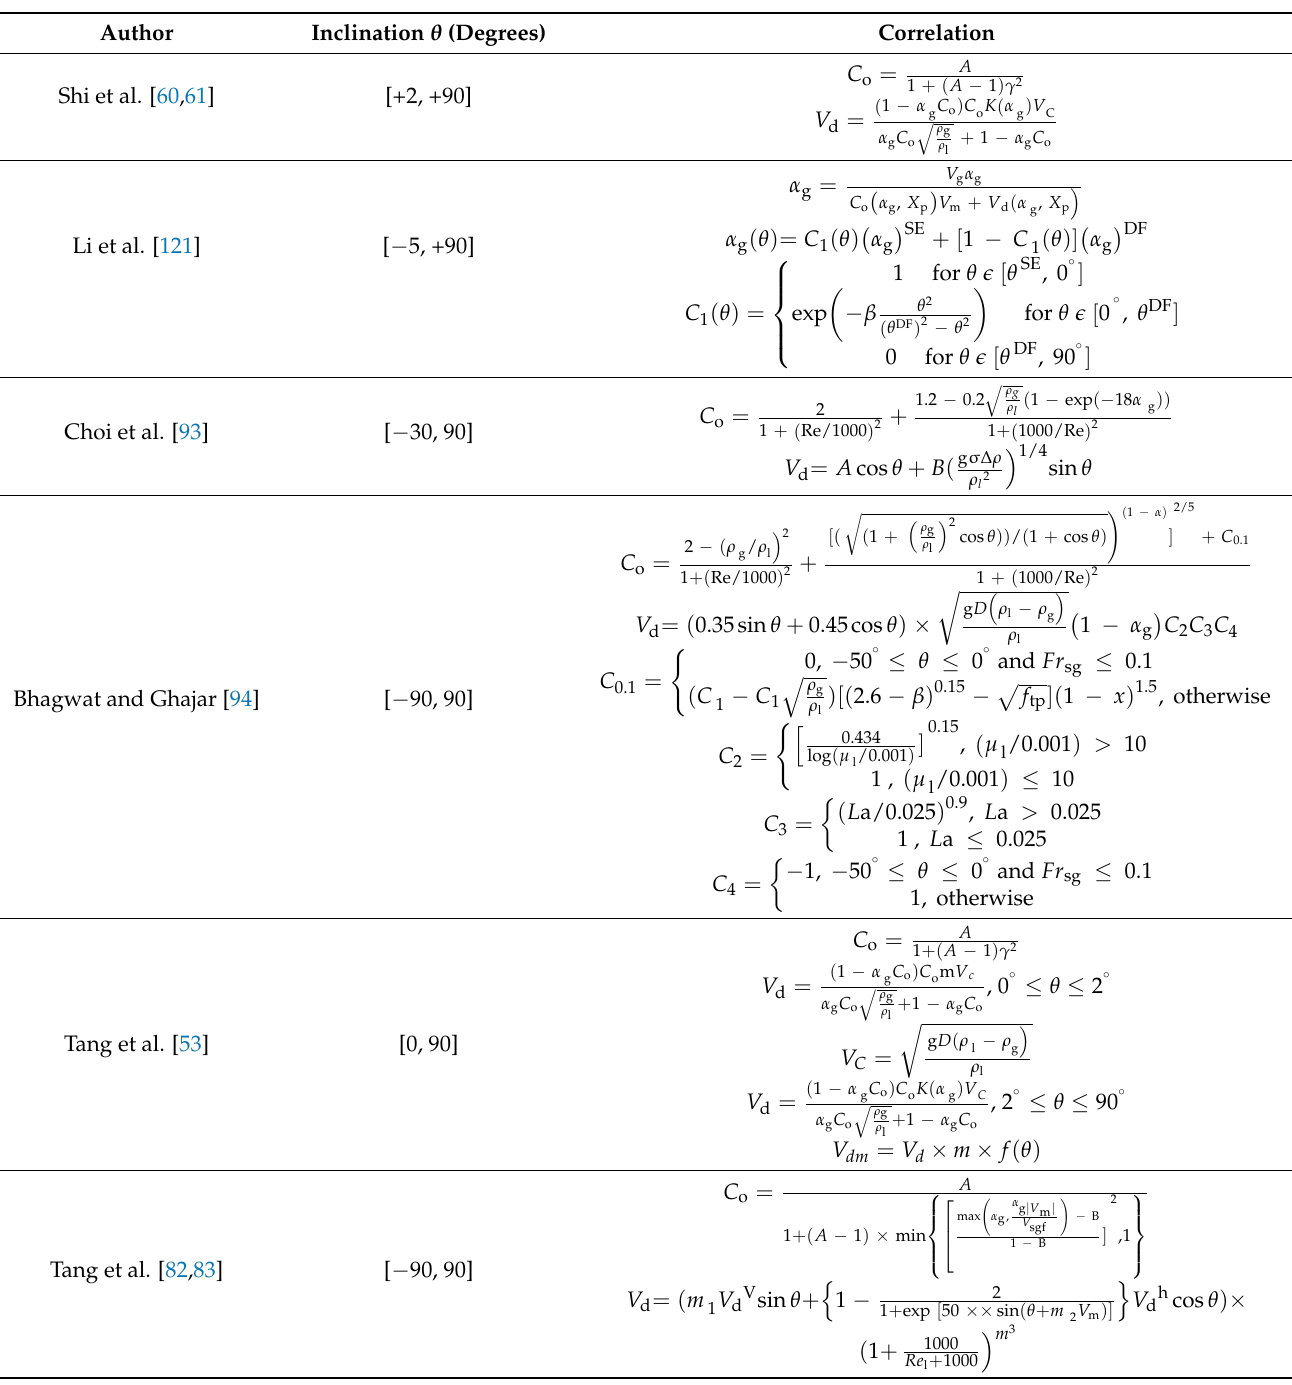
Table 2. Several unified DF models for coupled reservoir/wellbore